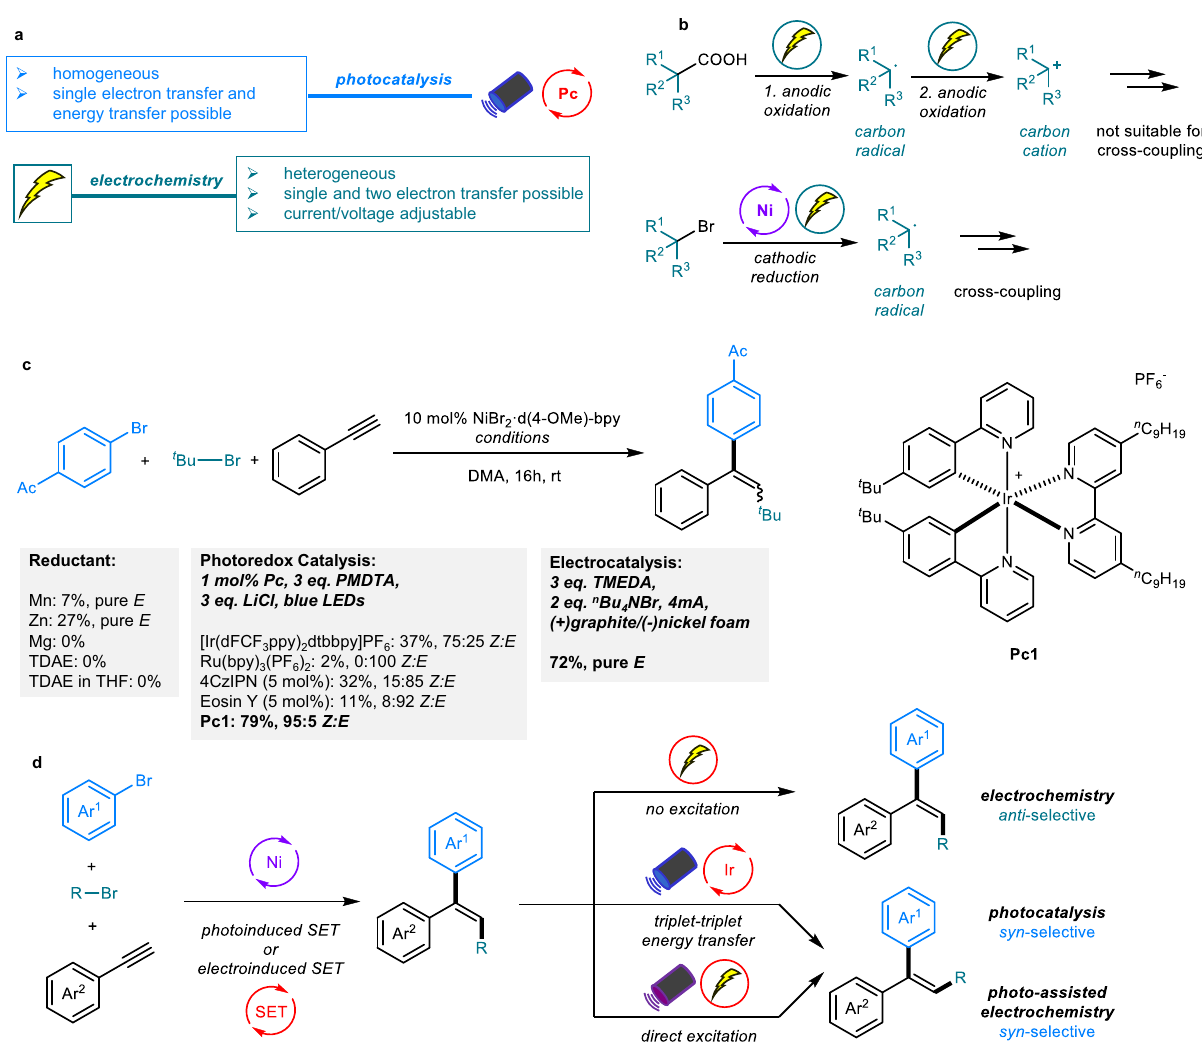
Fig. 1 Nickel-catalyzed arylalkylation of alkynes. a The advantages of photocatalysis and electrochemistry. b Limitation of the electrochemical oxidation pathway and potential of the electrochemical reduction pathway in the cross-coupling fi eld. c Initial results of nickel-catalyzed reductive cascade cross- couplings via the traditional reductant, electrochemical, and photocatalyzed pathways. d Stereocontrol of alkenes by switching between electrochemistry and photocatalysis. TDAE, tetrakis(dimethylamino)-ethylene; DMA, dimethylacetamide; PMDTA, N,N,N ′ ,N ′′ ,N ′′ -pentamethyldiethylentriamin; TMEDA, tetramethylethylenediamine; bpy, 2,2 ′